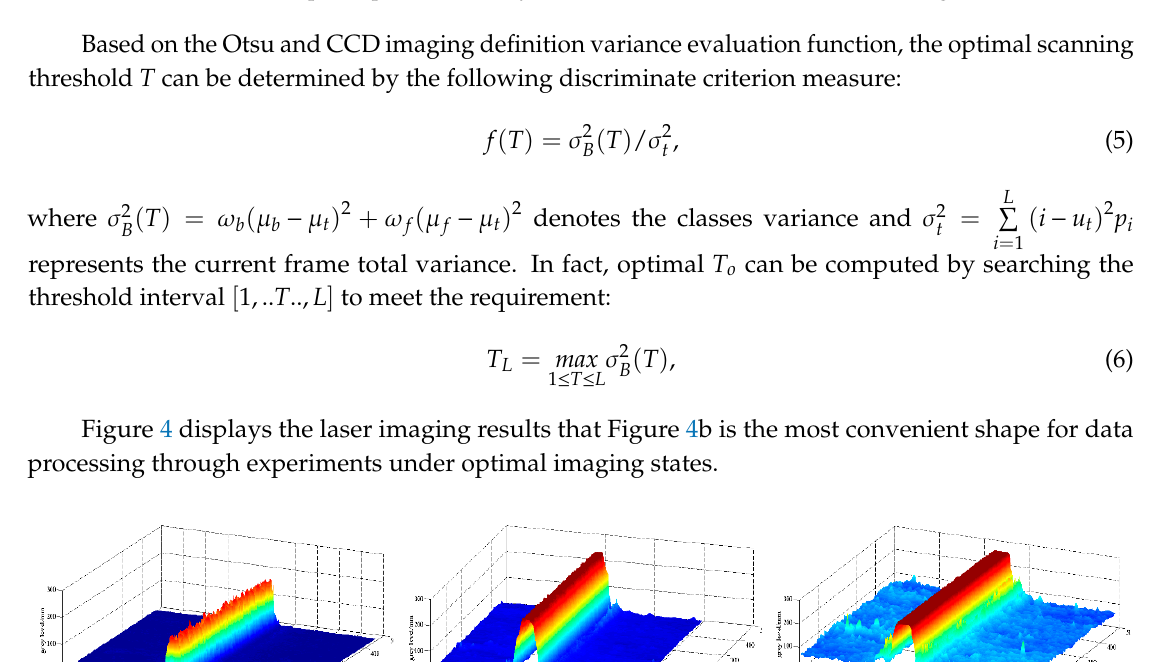
Figure 3. Laser stripe shape and intensity distribution counts at different CCD integral times.